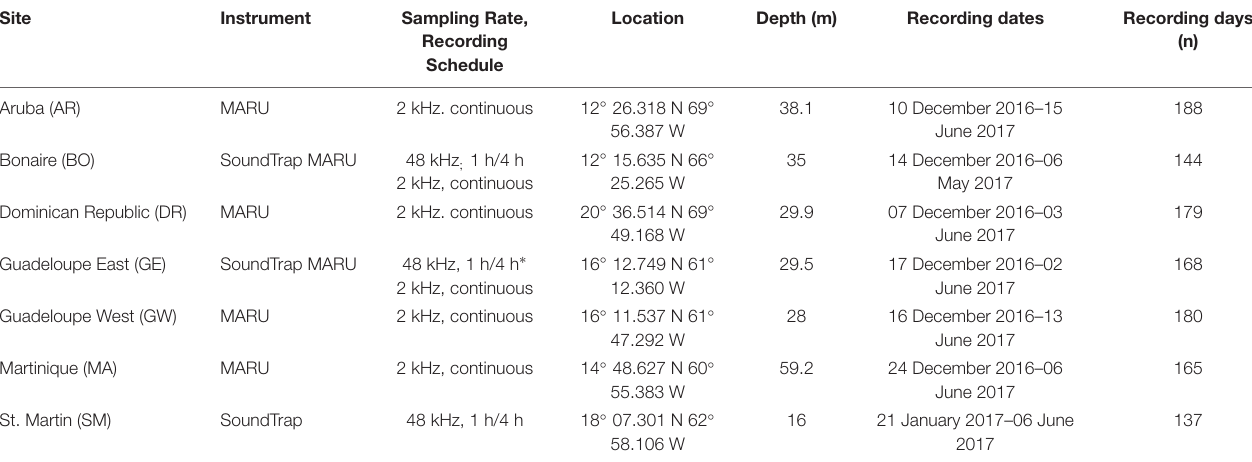
Site Instrument Sampling Rate,